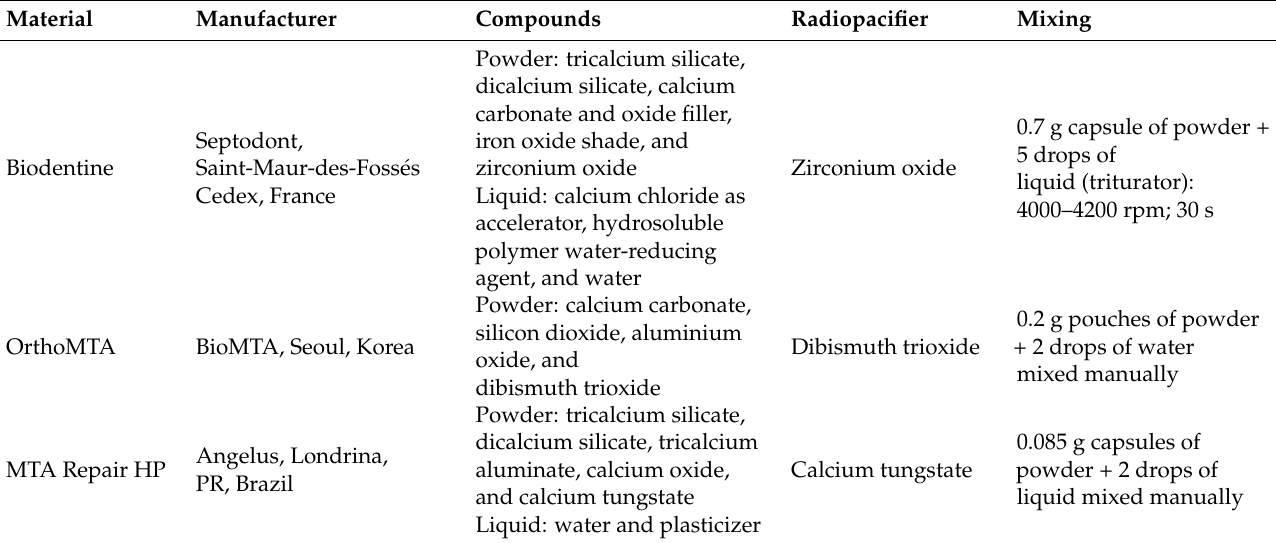
Table 1. Compositions of barrier